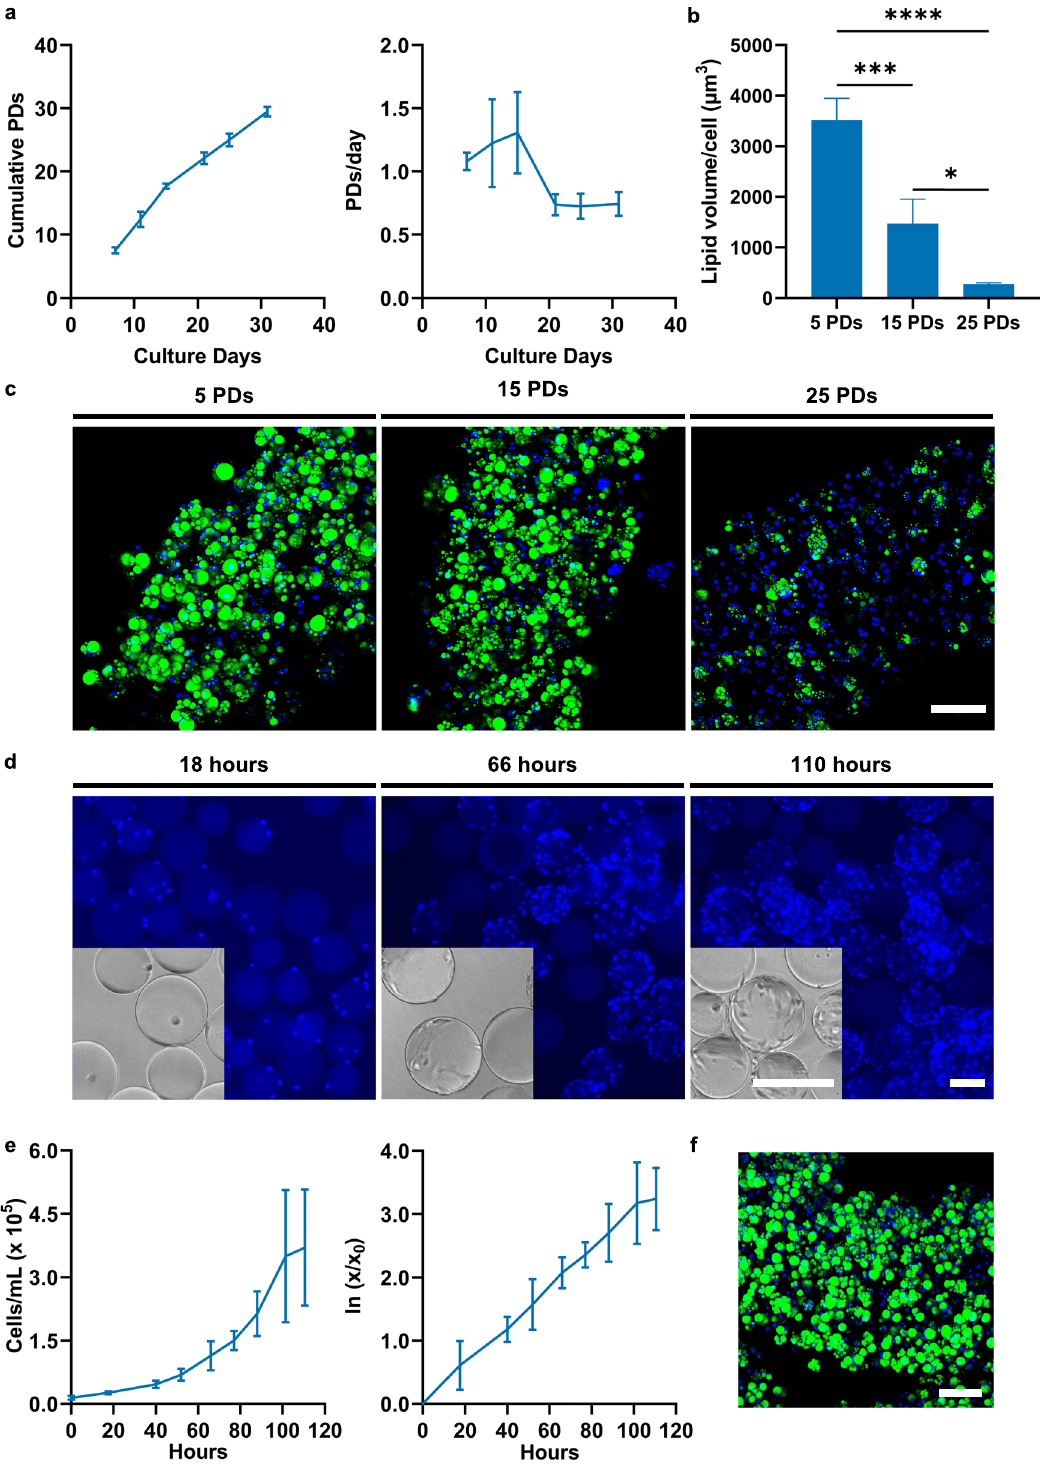
Fig. 5 Proliferation of FAPs in long-term and upscaled cultures. a Growth curve (left, showing cumulative population doublings) and growth rate (right panel) of FAPs in long-term culture. 95% con fi dence interval (CI) is indicated ( n = 3). b Lipid volume per cell for 28 day ADM- treated micro fi bres generated from FAPs that had undergone 5, 15, and 25 population doublings (PDs). Data is shown as mean ± sd ( n = 4). c Representative maximum intensity projection confocal microscopy images of 28 day differentiated micro fi bres corresponding to the samples quanti fi ed in b . Green = BODIPY, blue = Hoechst, scale bar = 100 µm. d Representative bright fi eld and immuno fl uorescence microscopy images of FAPs cultured on Cytodex 1 microcarriers after 18, 66, and 110 h of spinner fl ask culture. Blue = Hoechst, scale bars = 200 µm. e Original (left) and log-transformed (right panel) growth curves for FAPs cultured on Cytodex 1 microcarriers in spinner fl asks. 95% CI indicated ( n = 3). f Maximum intensity projection confocal microscopy image of 28 day ADM-treated micro fi bre created from FAPs proliferated on Cytodex 1 microcarriers. Green = BODIPY, blue = Hoechst, scale bar = 100 µm. P -values: * P ≤ 0.05; ** P ≤ 0.01; *** P ≤ 0.001; **** P ≤ 0.0001. ADM = adipogenic differentiation